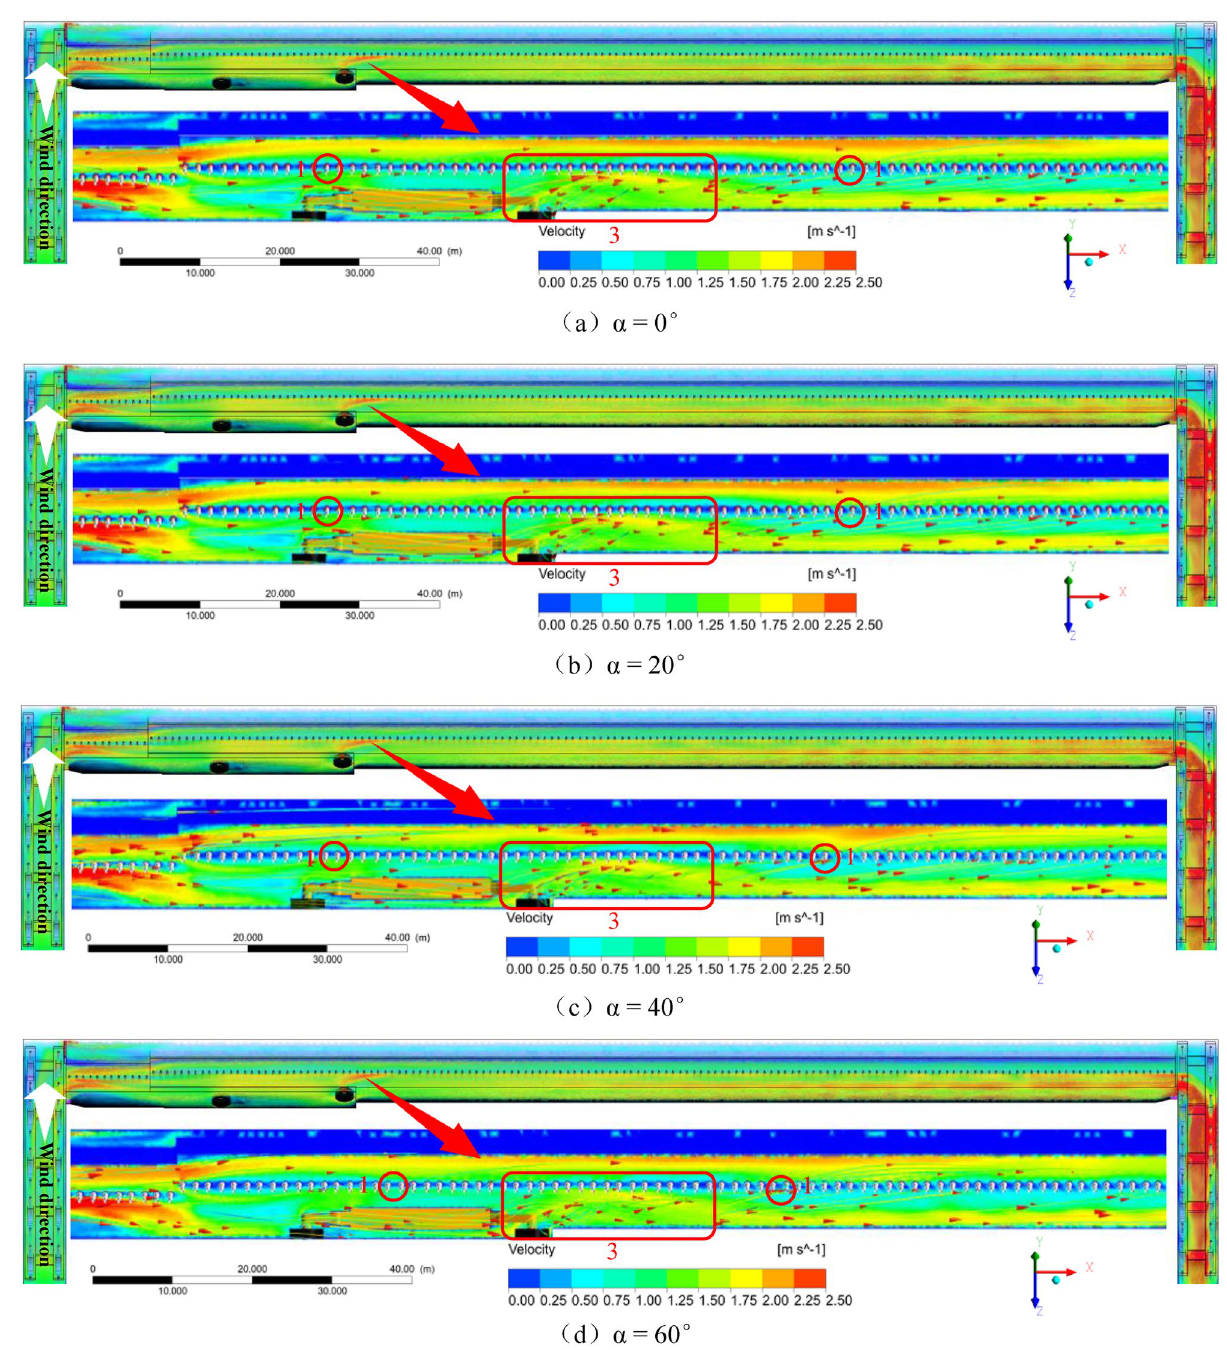
Figure 4. Wind flow renderings at different inclination angles (α = 0°, 20°, 40°,